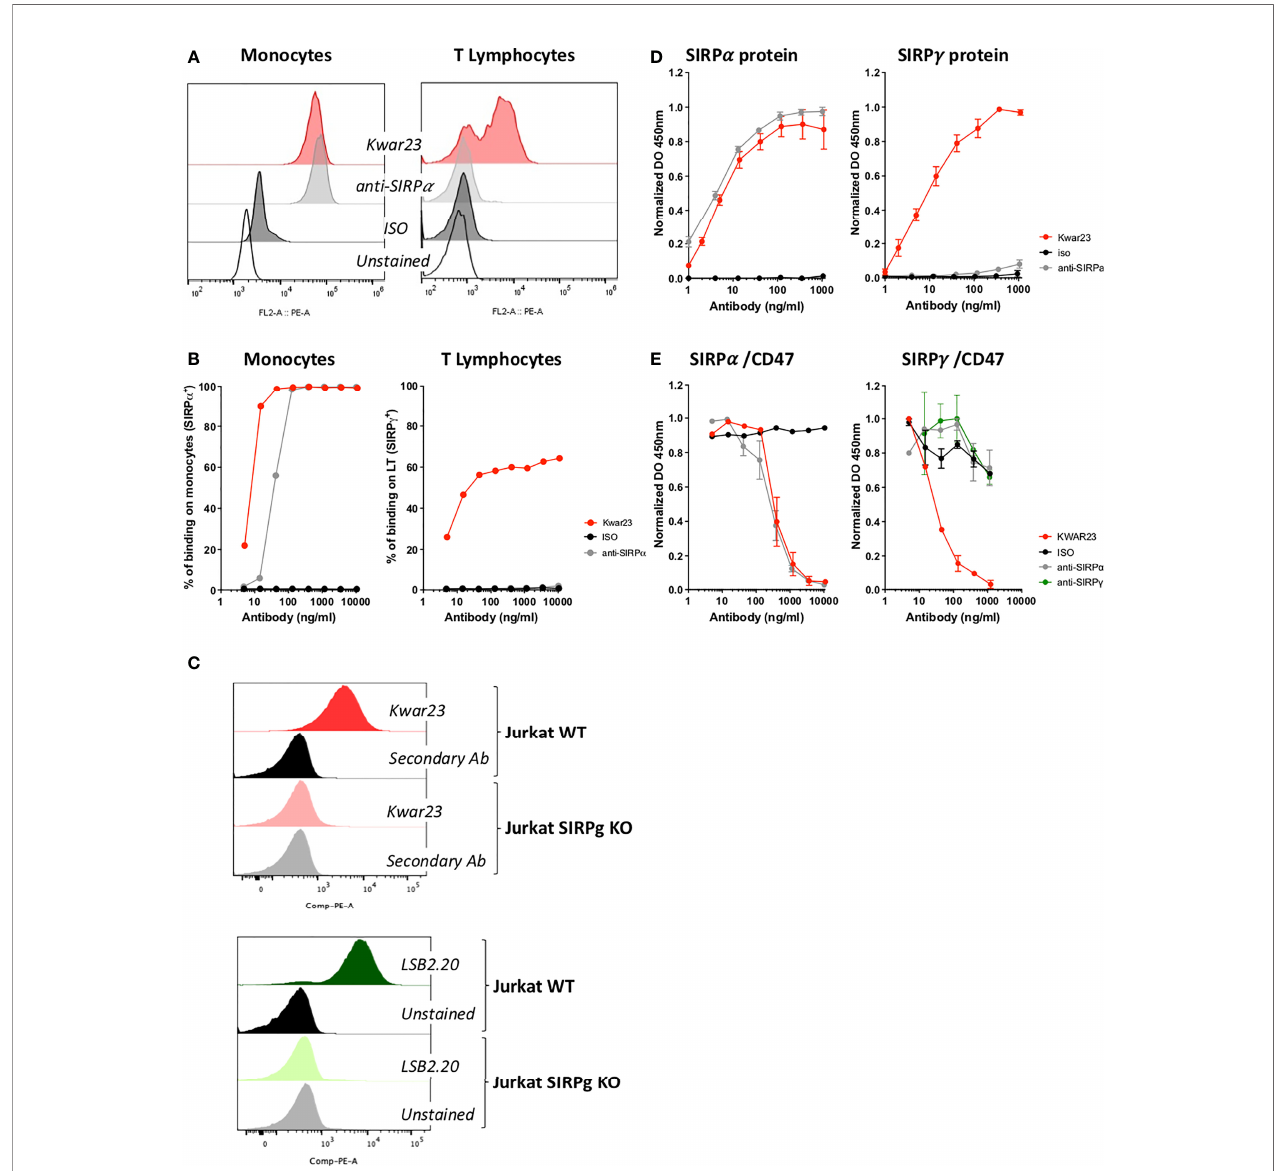
FIGURE 1 | The KWAR23 is a Pan SIRP mAb which impairs SIRP a and SIRP g interactions with CD47. (A) Human monocytes and T cells were labeled with KWAR23, anti-SIRP a mAb (18D5) or an isotype control (ISO) all at 10,000 ng/ml and further analyzed by FACS. (B) The percentage of stained cells (monocytes and T cells) is presented regarding the concentration of mAb ( n = 1). (C) KWAR23-binding speci fi city towards SIRP g was evaluated by FACS staining on wild-type (WT) and SIRP g − KO Jurkat cells (upper overlay). LSB2.20 (anti-SIRP g )KWAR23 recognized staining was used as control (lower overlay). (D) Speci fi city of mAb used in (A) and (B) were assessed by ELISA against recombinant SIRP a and SIRP g proteins. Binding activity is presented as normalized absorbance (DO) at 450 nm in function of concentration of mAb (ng/ml), n = 2 – 4 individual experiments (mean ± SEM). (E) Antagonist activity of the KWAR23, the anti-SIRP a (18D5), and the anti-SIRP g (LSB2.20) mAbs to SIRP a /CD47 (left panel) and SIRP g /CD47 (right panel) binding was measured by ELISA and presented as normalized absorbance (DO) at 450 nm in function of mAb added (ng/ml). n = 3 individual experiments (mean ±